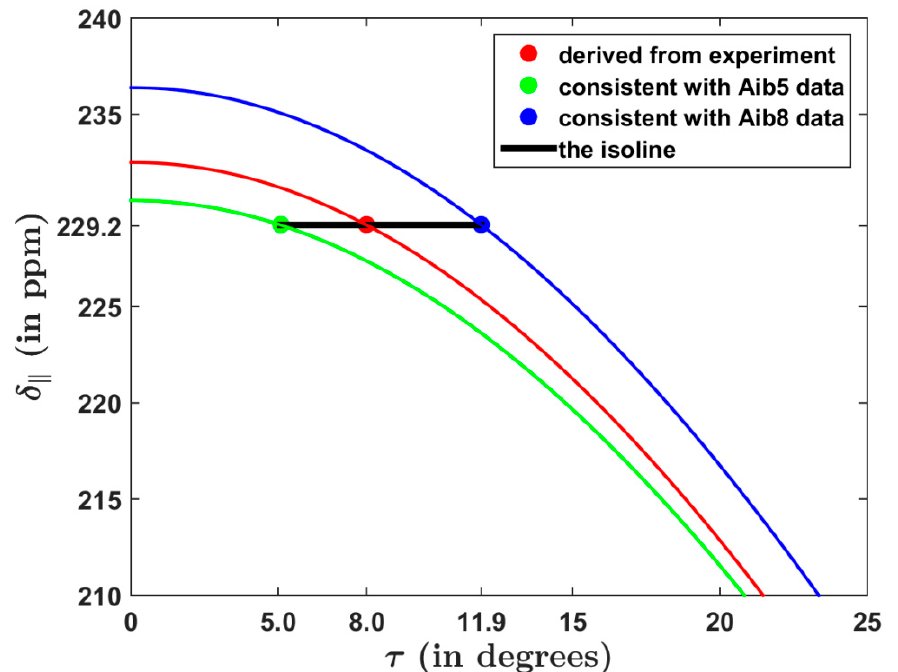
Figure 3. The dependence of the unique component of the 15 N chemical shift tensor upon the tilt angle in the ALM-18 model described in the text. The expression for simulated lines is given in Section 3.2, while the underlying data are specified in Section 2.2.